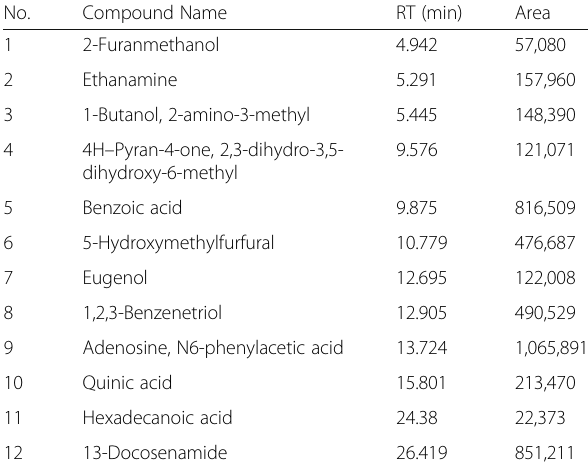
Table 1 Quantification of compounds in KD5040 using gas chromatography-mass spectrometry